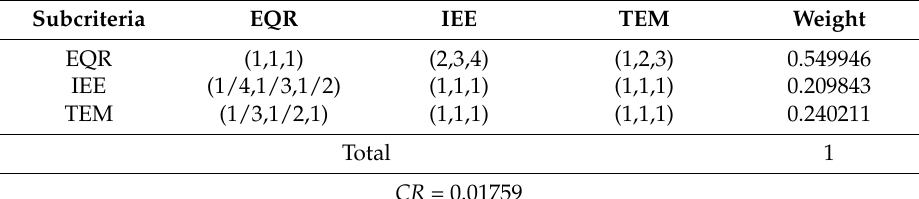
Table A6. Comparison matrix for ENF based on